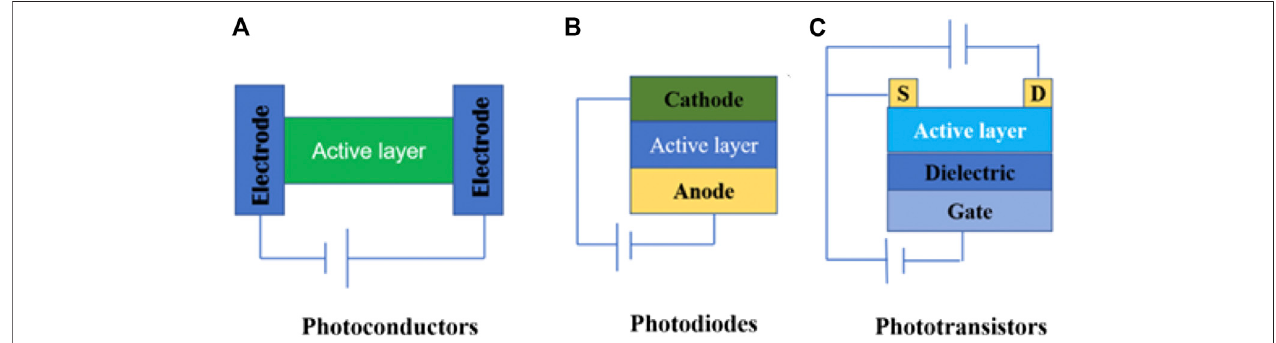
FIGURE2| Typicaldevicecon fi guration ofCPL-sensitivephotodetectors. (A) Photoconductors. (B) Photodiodes. (C) Thedevicecon fi gurationofphototransistor. S and D represent the source and drain electrodes of the phototransistors,